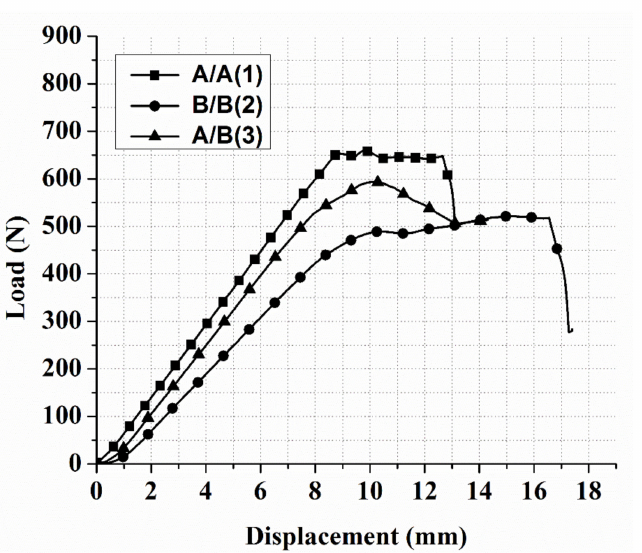
Figure 4. Load–displacement curves for CFRP composites with different stacking sequences.